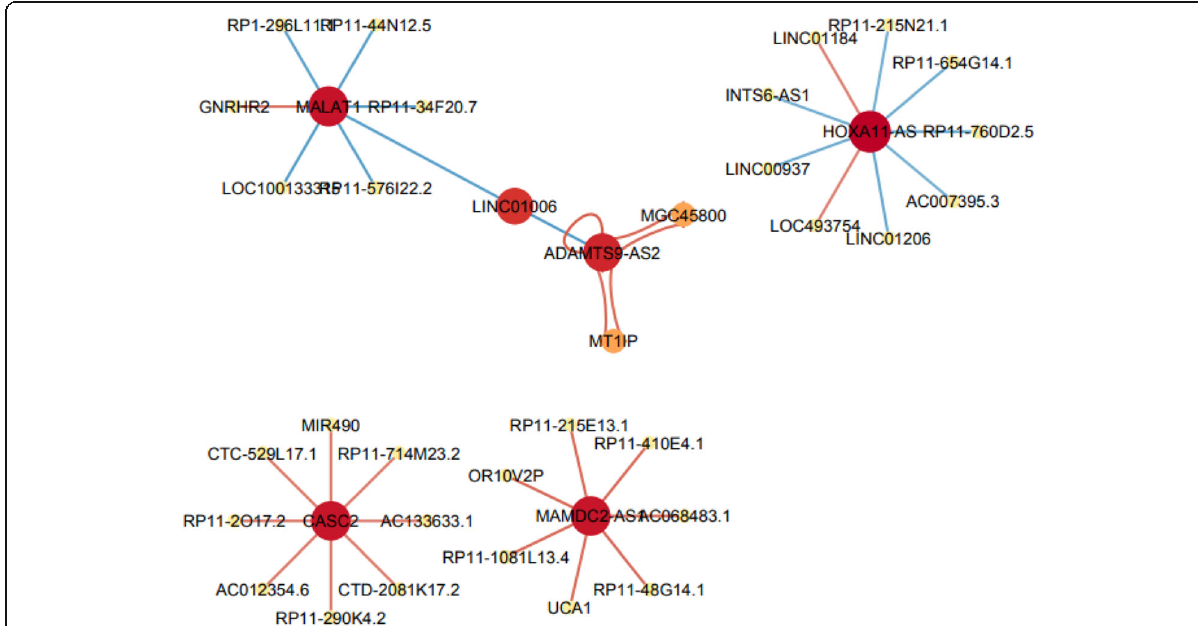
Fig. 2 Co-expression network of deferentially expressed and six candidated lncRNAs in glioma tissues in comparison with the normal brain tissues